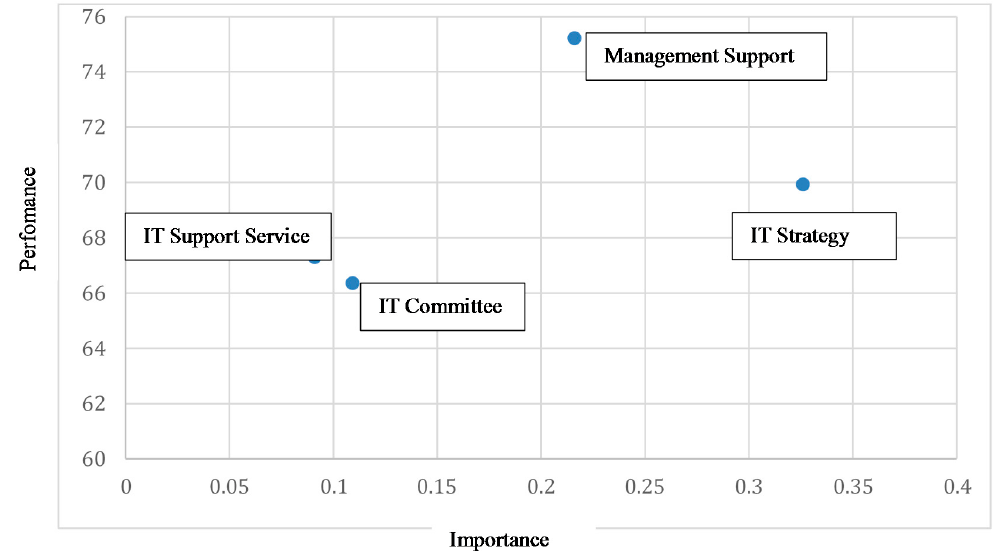
Figure 2. Importance-performance matrix analysis (IPMA) for audit technology performance.